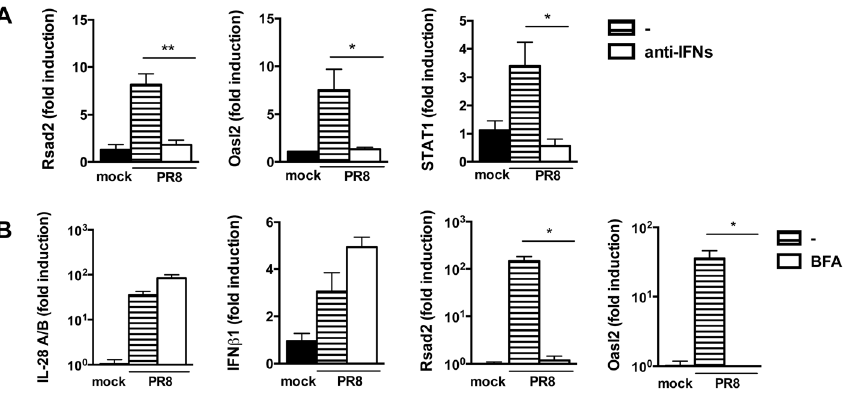
Figure 8. Residual IFN production is responsible for ISG induction in MAVS 2 / 2 epithelia. (A) qRT-PCR analysis of Rsad2, Oasl2 and STAT1 in MAVS 2 / 2 epithelia infected with PR8 in the presence or absence of blocking anti-IFNAR and neutralizing anti-IL28A/B antibodies. (B) Wild-type epithelia were PR8-infected in the presence or absence of brefeldin A (2.5 m g/ml). Expression of the indicated genes was determined by qRT-PCR at 24 hpi. All transcripts were normalized to HPRT levels and then expressed as fold induction relative to the mean of mock infected controls, + / 2 SEM. Asterisks indicate differences that are statistically significant (unpaired t test; *, P , 0.05; **, P , 0.01).